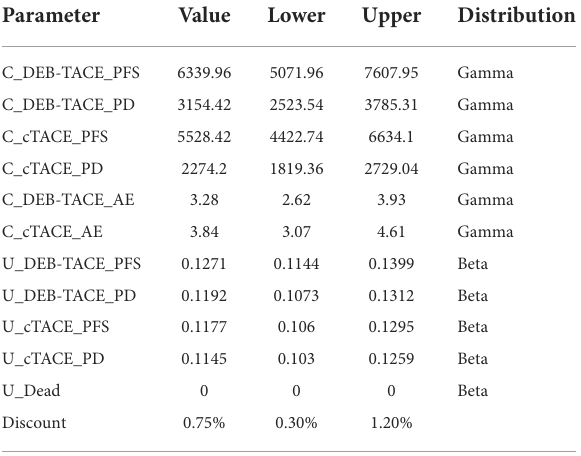
TABLE 4 Summary of costs and utility values. TABLE 5 Result of cost-effectiveness